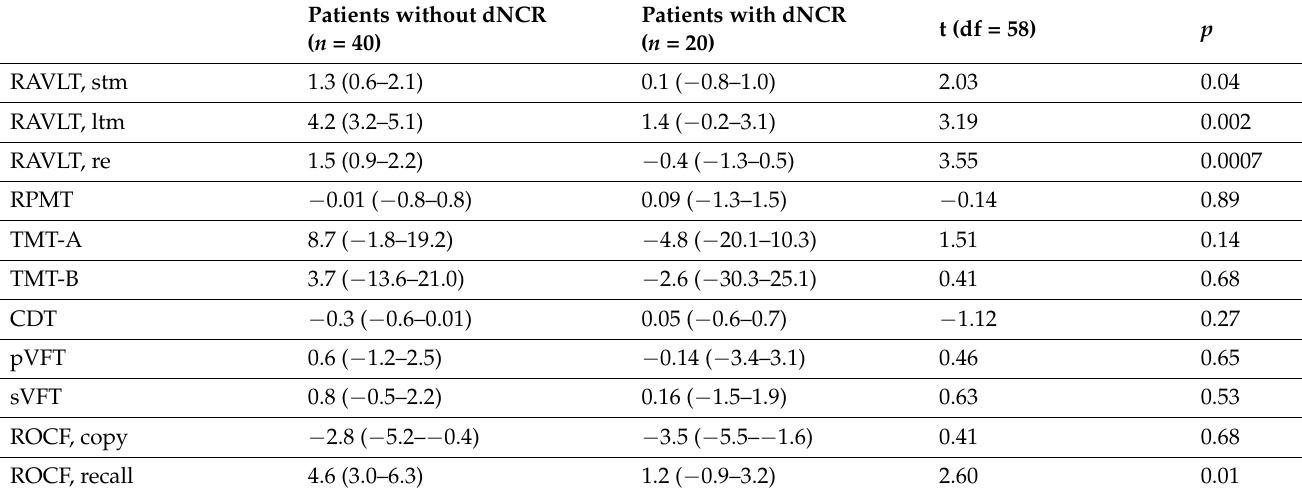
Figure 2. Pulsatility index (Pi) at different time points: baseline (T1), after the induction of anesthesia (T2); 30 min after the start of the Trendelenburg position (T3); one hour from the start of ST (T4), before ST removal (T5); before waking up, ten minutes after the end of ST (T6). Vertical bars denote 95% CI. The significantly altered neuropsychological tests after surgery were the Rey Audi ‐ tory Verbal Learning Test (RAVLT) and the Rey–Osterrieth complex figure (ROCF) test recall (see Table 2). Table 2. Neuropsychological tests (difference between postoperative and preoperative values) in patients with and without dNCR. RAVLT, Rey Auditory Verbal Learning Test; stm, short-term memory; ltm, long-term memory; re, recency effect; PPMT, Raven’s Progressive Matrices test; TMT, trail making test; CDT, clock drawing test; pVFT, phonemic verbal fluency test; sVFT, semantic verbal fluency test; ROCF, Rey–Osterrieth complex figure test. Values are means (95% confidence intervals). Patients without